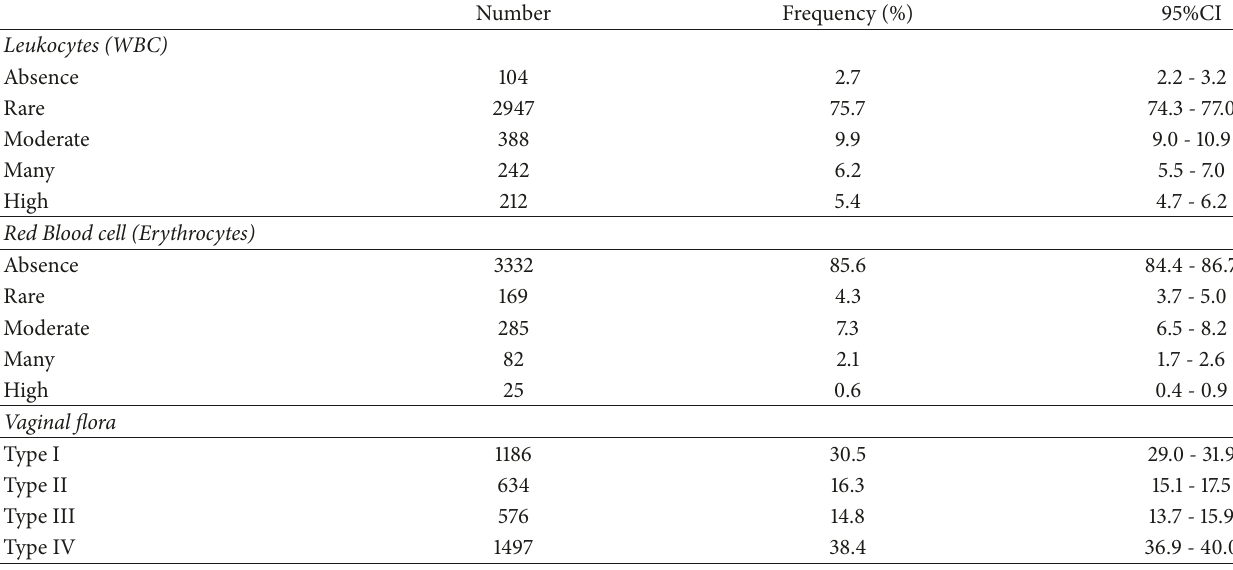
Table 2: Microscopic findings among participating